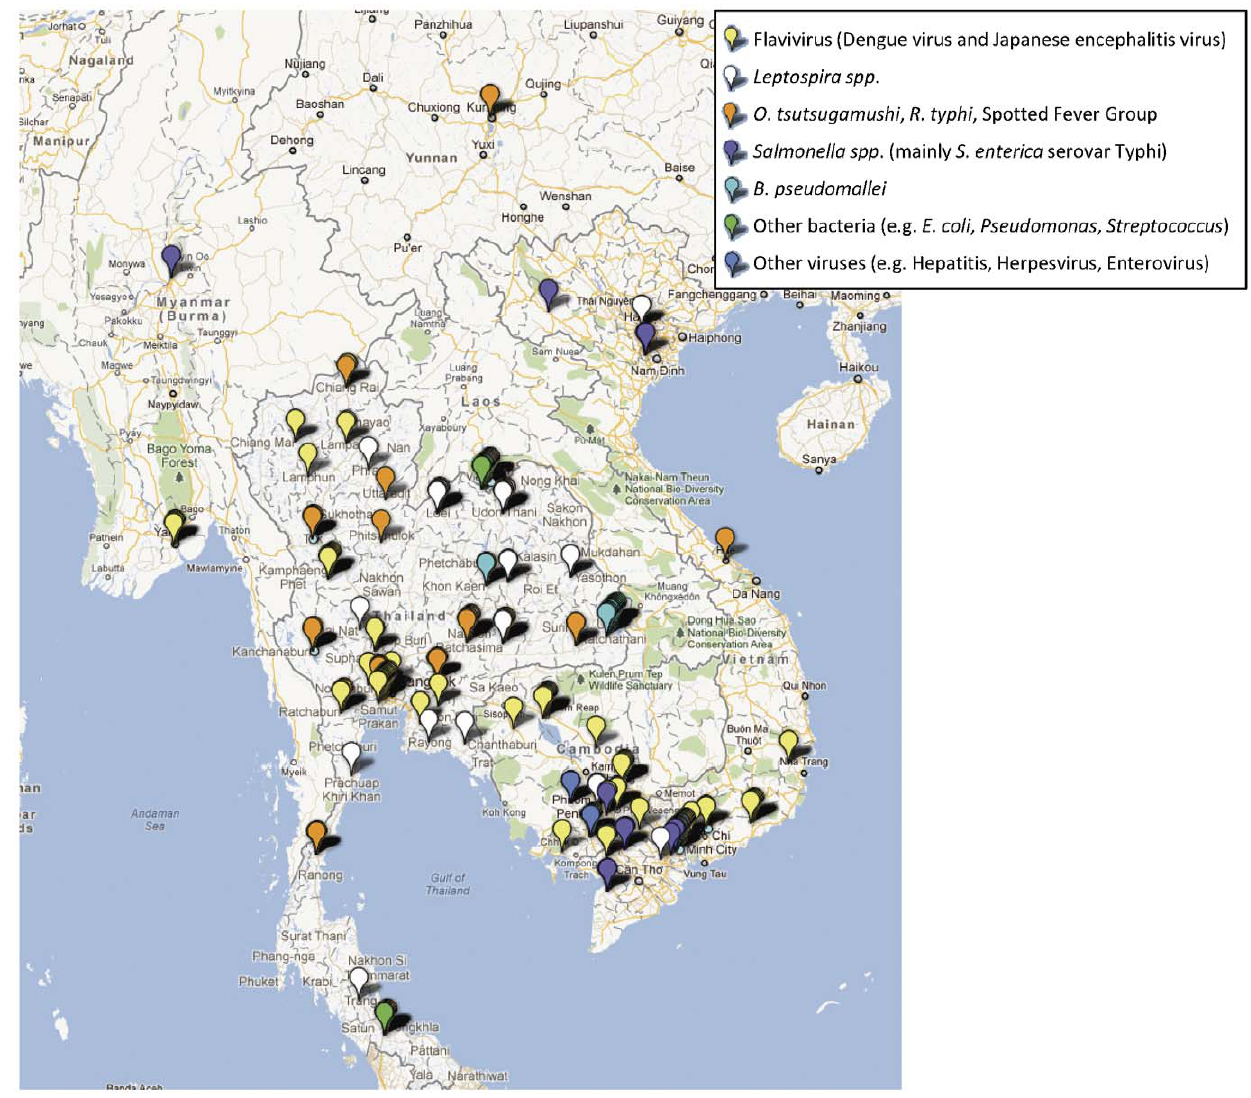
Figure 2. Study sites in the Mekong region where major aetiologies of infectious febrile illnesses have been reported.